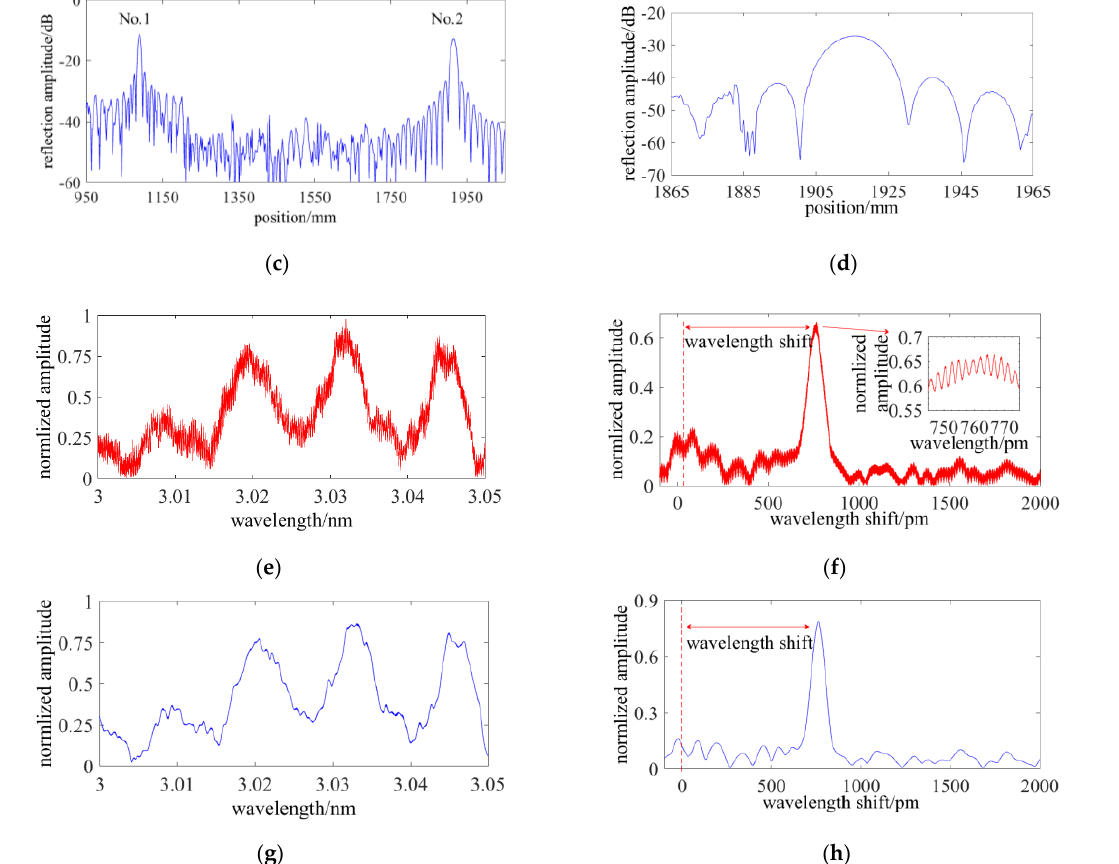
Figure 6. Experimental results of OFDR based on WT method: ( a ) distributed sensing result of two FC / APC reflective end surfaces; ( b ) the influence of the σ on the spatial resolution; ( c ) the spatial resolution of first and second FC/APC reflective end surfaces; ( d ) the distributed reflection spectrum of the No.2 FC/APC reflective end surface processing by the method demonstrated in Equation (13); ( e ) Rayleigh scattering (RS) spectrum of a fiber sensing gauge located at 1.4 m without frequency shift, the wavelength of x axis is relative to 1550 nm; ( f ) cross-correlation result of RS spectrum without frequency shift; ( g ) RS spectrum of a fiber sensing gauge located at 1.4 m with frequency shift, the wavelength of x axis is relative to 1550 nm; and, ( h ) cross-correlation result of RS spectrum with frequency shift.